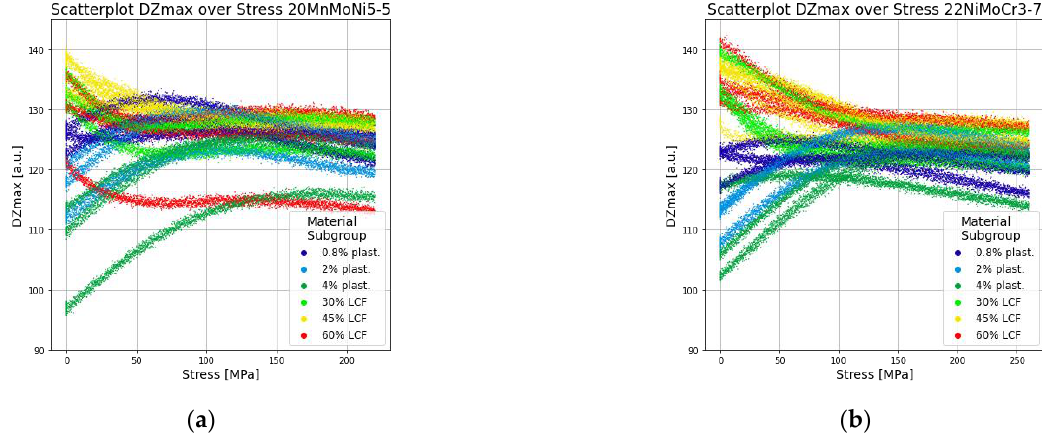
Figure 9. Stress-dependent scatterplot of feature DZmax: ( a ) 20MnMoNi5-5 and ( b ) 22NiMoCr3-7.